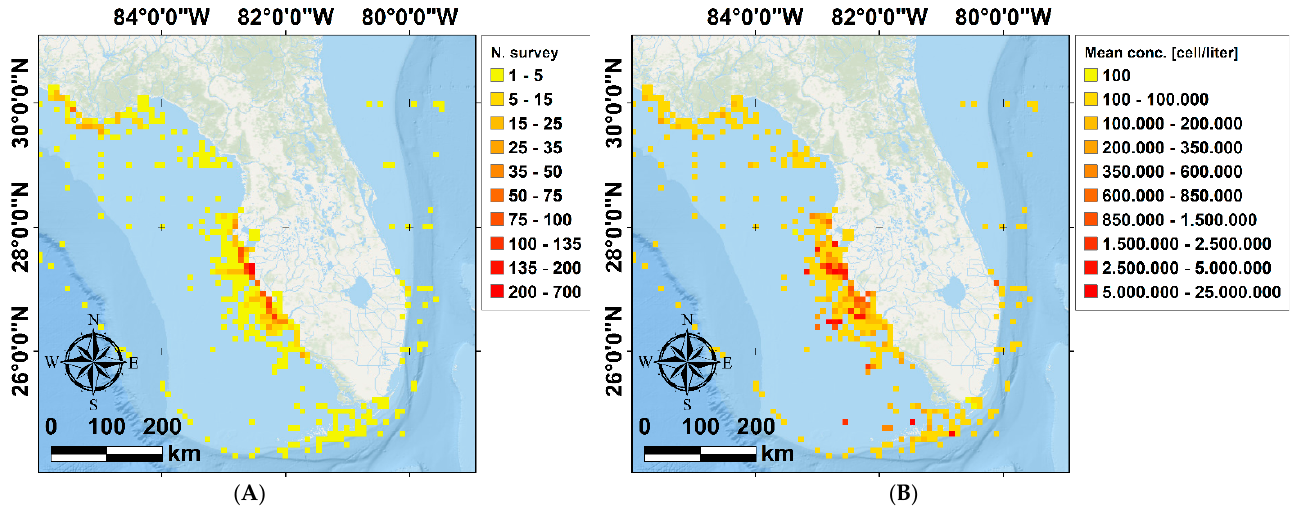
Figure 4. Heat maps representing the number of observations ( A ), and the average concentration in cells/liter ( B ) of K. brevis collected by FWC and FWRI (Fish and Wildlife Conservation Commission—Fish and Wildlife Research Institute) in the time frame where the environmental data were available (from 1987 through 1998, see Figure 1). The heat maps are represented using a regular grid. The dimension of the cells constituting the grid is 10 km × 10 km.